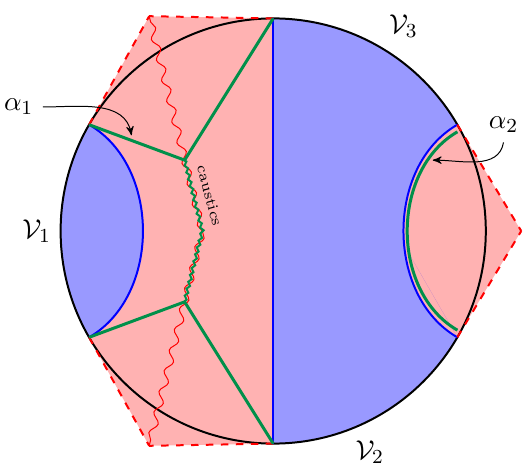
Figure 19. If the entanglement wedge is not fully connected, then the fact that the dividing curves do not intersect means any complete cross-section of F will need to include